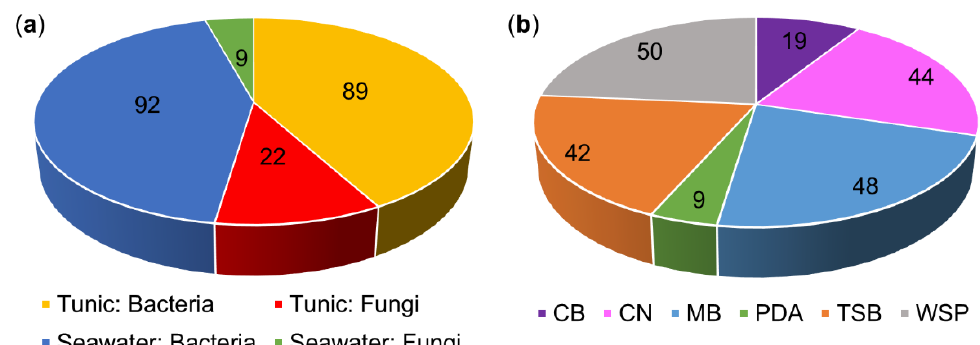
Figure 1. Number of microbial strains isolated from the tunic of C. intestinalis and seawater reference. Numbers are given separately for bacteria and fungi from tunic and seawater samples ( a ) and for the six different cultivation media ( b ). CB: C. intestinalis medium adjusted to the salinity of the Baltic Sea, CN: C. intestinalis medium adjusted to the salinity of the North Sea, MB: marine broth, PDA: potato